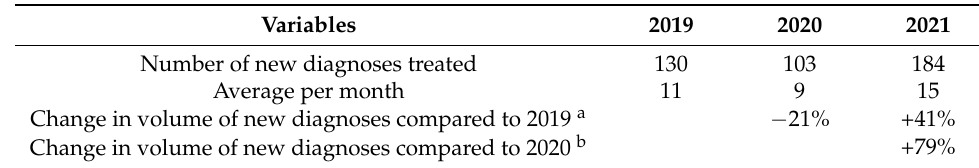
Table 3. Lung cancer diagnoses in the three cohorts.